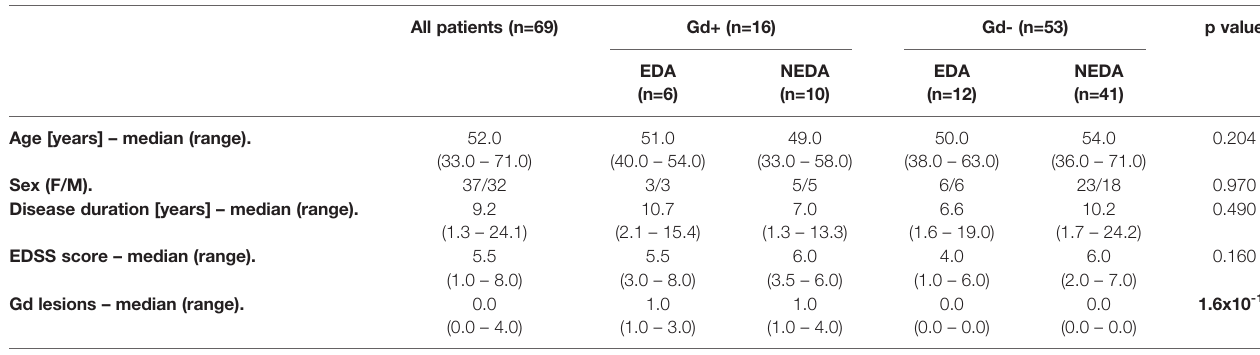
TABLE 1 | Baseline data and patient characteristics.